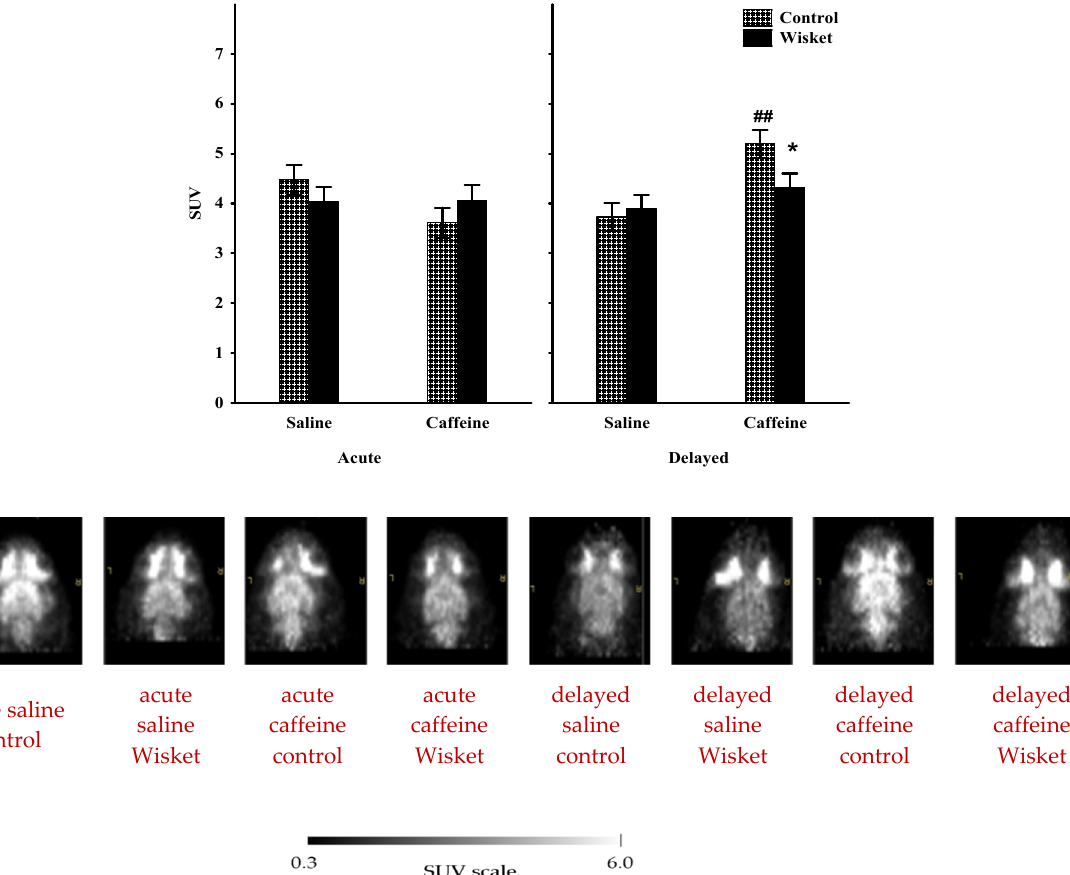
Figure 2. The mean 18 F-FDG PET SUV with standard error bars (with their representative horizontal PET images and SUV scale) in the whole brain of control and Wisket animals 30 min or one day after saline or caffeine administration. Symbols denote significant differences between the two groups (*) and compared to saline (##); p < 0.05 or p < 0.01 with one or two symbols, respectively. Since the delayed caffeine effect was significant at the whole-brain level, the metabolic rates of four brain areas were also analyzed in Series